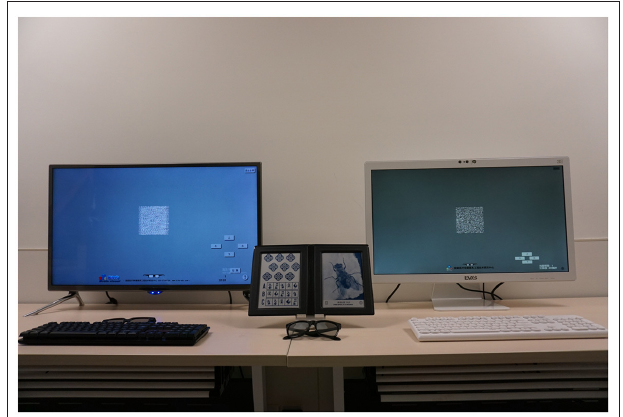
FIGURE 1 | Photographs of glasses-free (right), polarized (left), and Titmus (middle) stereotest systems.